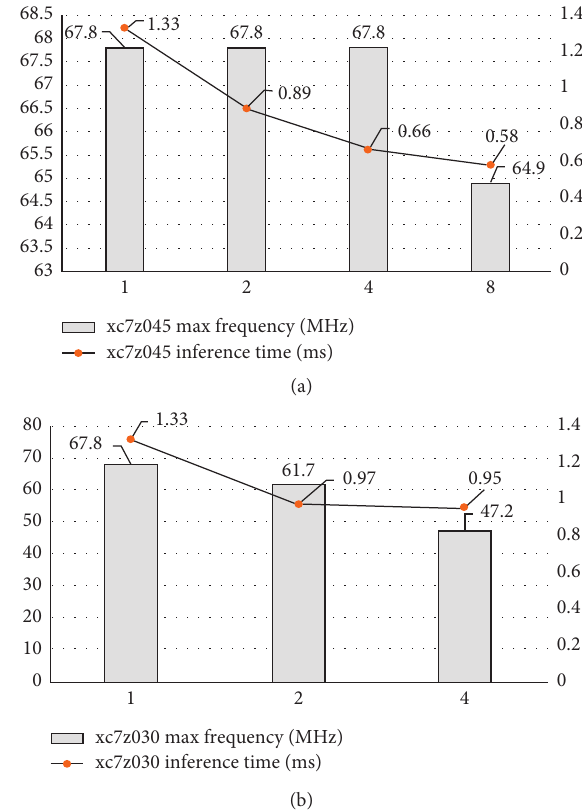
Figure 10: Max frequency and inference time for the Zynq-7000